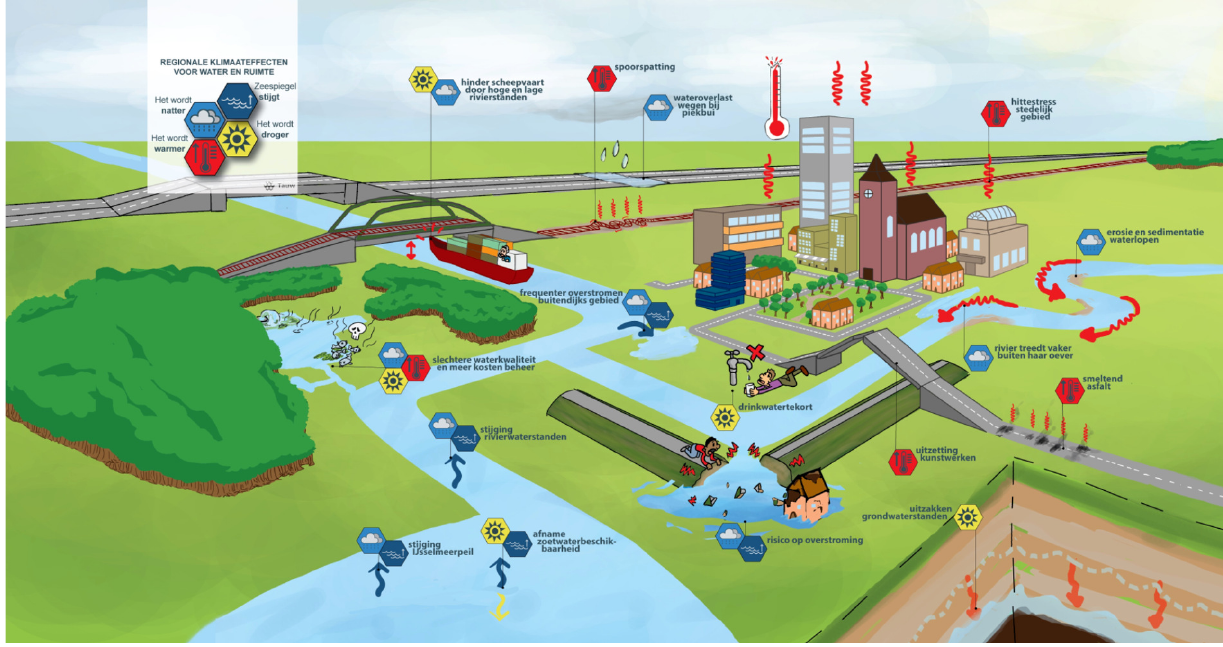
Figure 6. RIVUS region: Example of a birds‐eye view to illustrate potential climate impacts in the region. Source: Foundation Climate Adaptation Services (n.d.‐b).